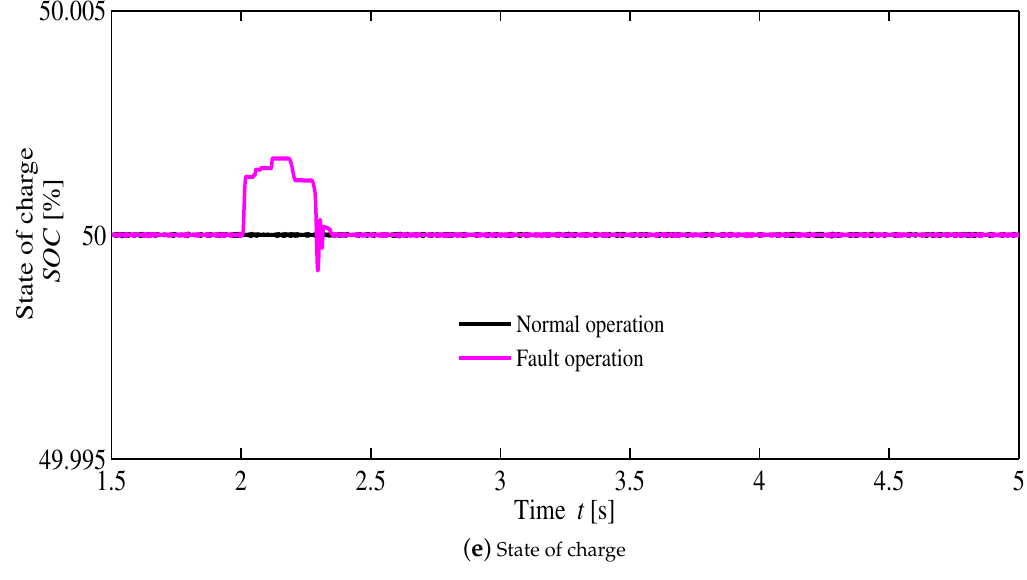
Figure 12. Simulation results of DC bus voltage, grid voltage, and battery parameters.